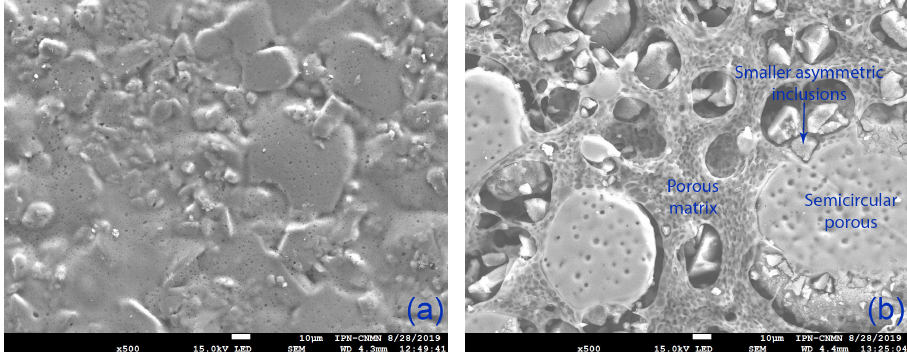
Figure 6. SEM images of the superficial view of ( a ) CEM (500 × ) and ( b ) Modified-CEM (500 ×